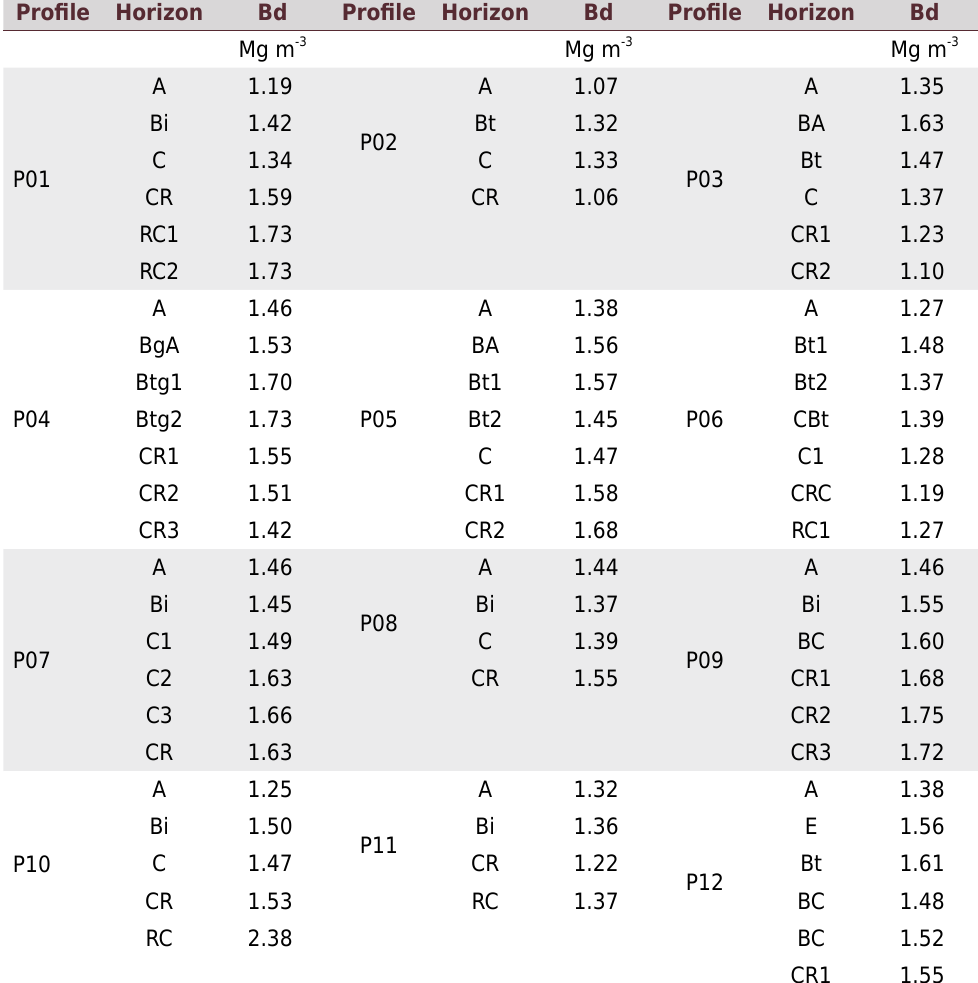
Table 2. Bulk density along the regolith profiles in the Southeast (Guerra, 2015) Profile